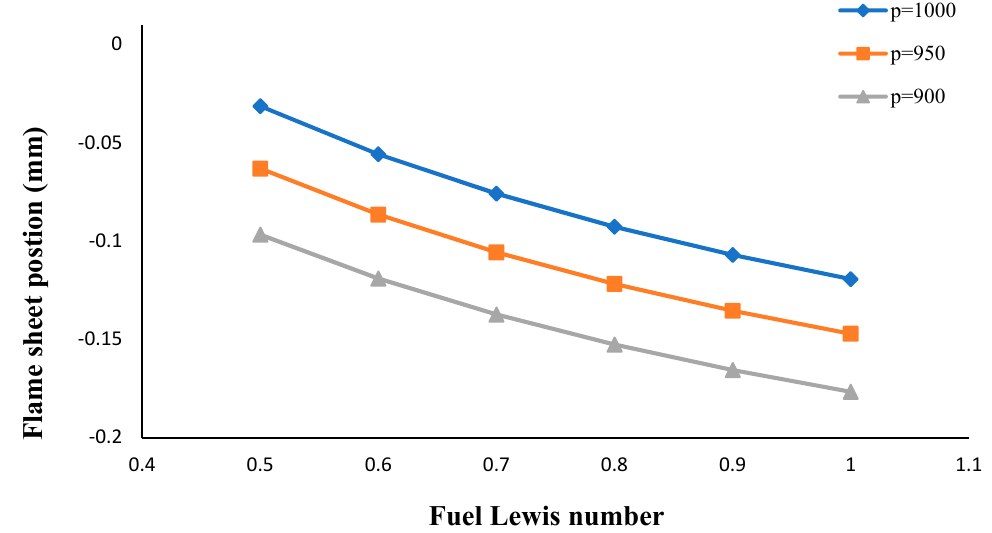
Figure 8. Flame temperature against the fuel Lewis number for several values of mass particle concentration.